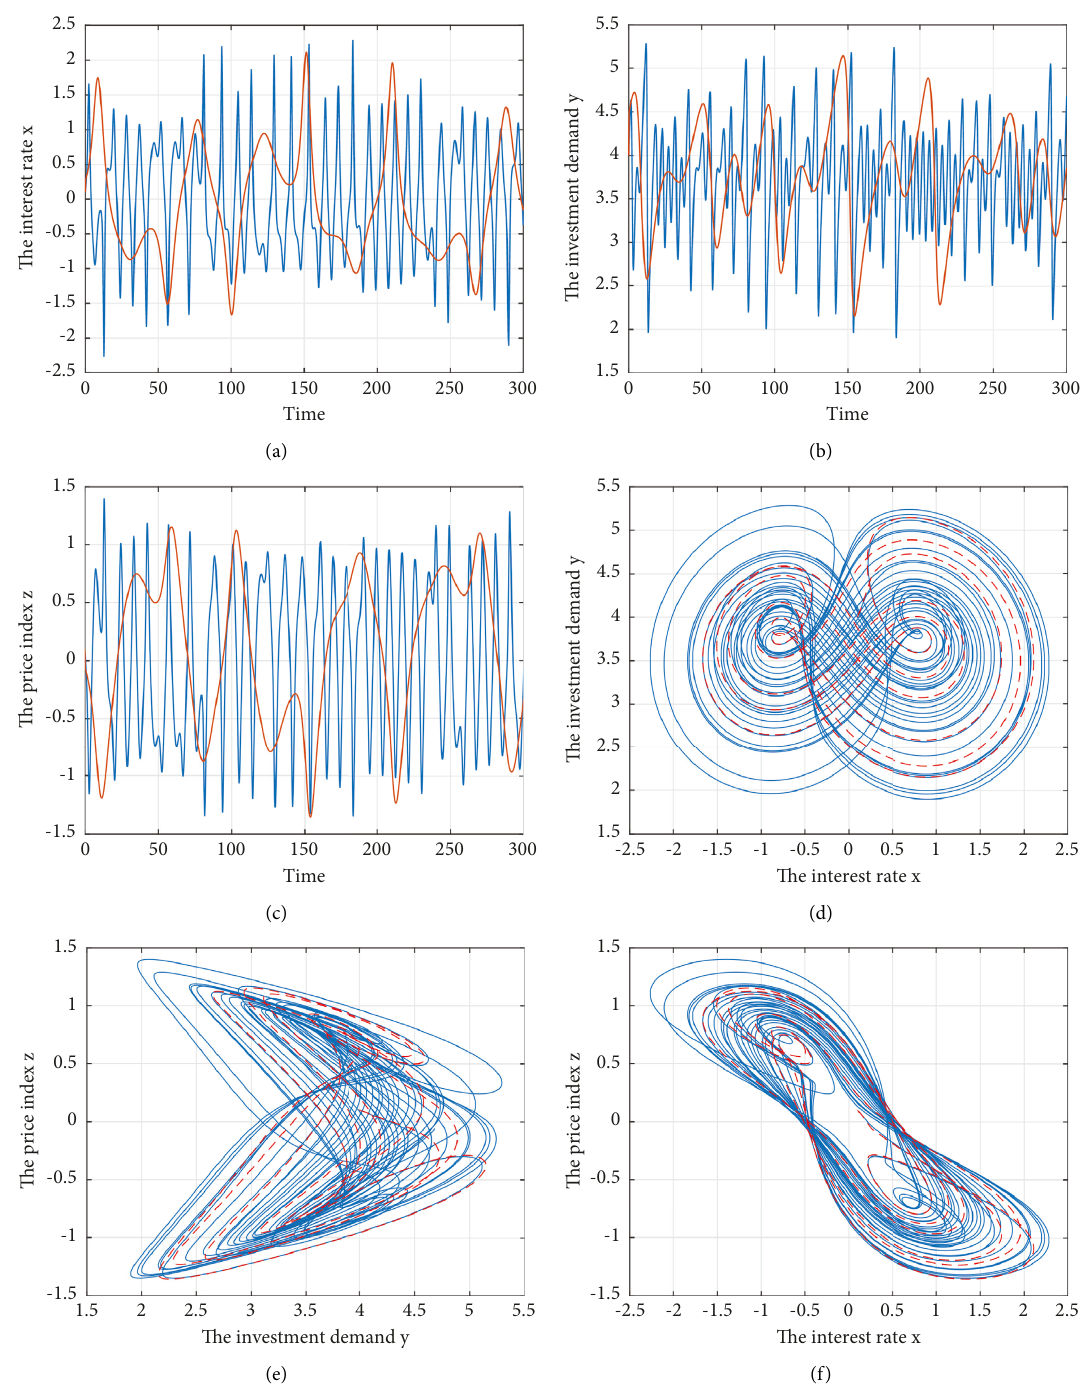
Figure 1: Time series analysis and chaotic behaviour of the proposed fractional model (2) of the financial system with the fractional order ϑ � 0 . 35 to conceptualize the influence of ϑ on the system while the other parameters a , b , and c are